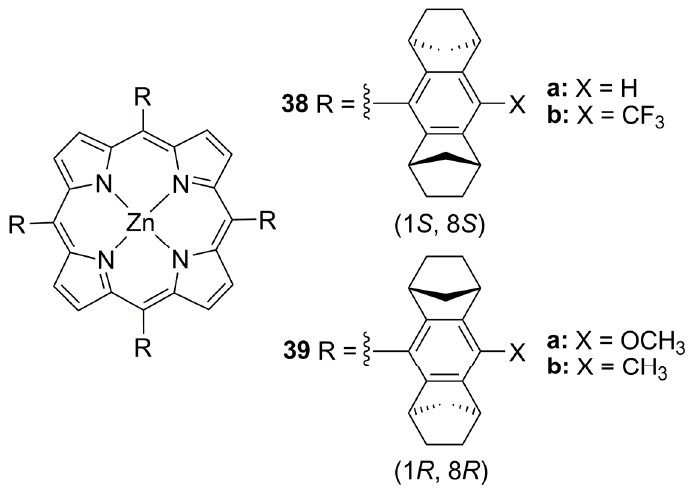
Figure 31. Chiral zinc-porphyrin